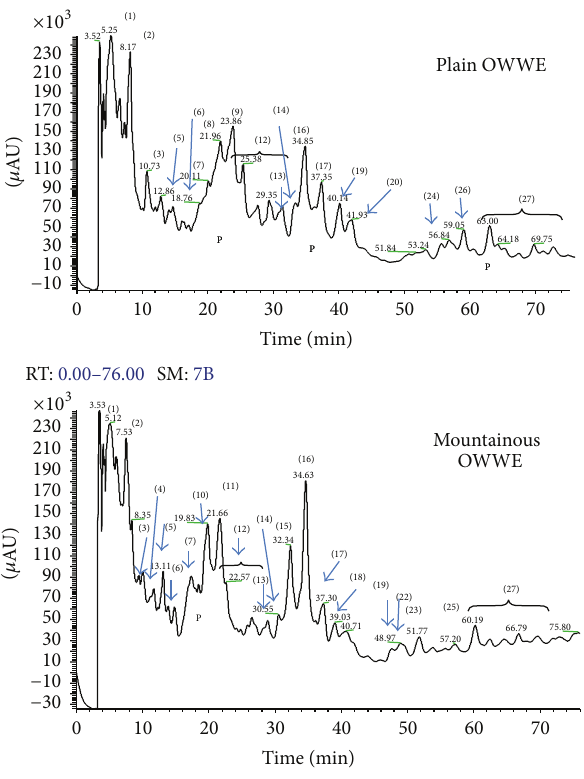
Figure 2: HPLC chromatogram of the phenolic profile of OWWE. Peaks identities: (1) hydroxytyrosol glucoside, (2) hydroxytyrosol, (3) tyrosol, (4) vanillic acid (5) sinapic acid, (6) syringic acid, (7) caffeic acid, (8) p-coumaric acid, (9) dihydroxymandelic acid, (10) vanillin, (11) 3,4,5 trimethoxybenzoic acid, (12) secoiridoids deriva- tives, (13) verbascoside, (14) rutin, (15) luteolin-7-rutinoside, (16) luteolin-7-glucoside,(17)luteolin,(18)apigenin,(19)n¨uzhenide,(20) quercetin, (21) apigenin-7-rutinoside, (22) apigenin-7-glucoside, (23) oleuropein, (24) oleuropein aglycon (25) ligstroside, (26) ligstroside aglycon, (27) secoiridoids derivatives and (P) polymeric substances.